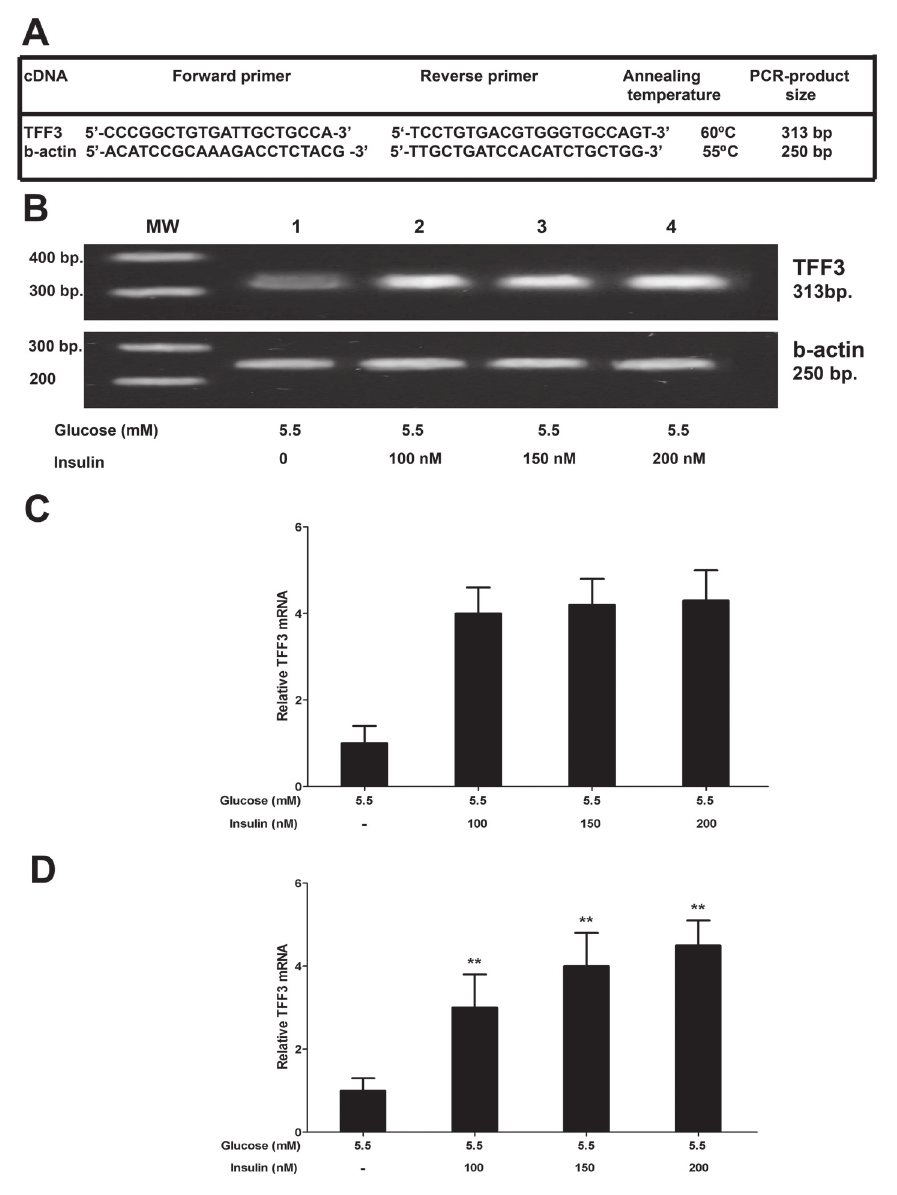
FIGURE 3. Quanti fi cation of differentially-expressed TFF3 mRNA by RT-PCR and RTq-PCR: (A) Speci fi c primers and annealing temperatures employed in semi-quantitative PCR (RT-PCR). (B) RT-PCRs for TFF3 and β -actin were carried out from cell culture samples divided in four groups: Cells treated only with glucose 5.5 mM (lane 1), cells treated with glucose 5.5 mM plus insulin at 100 nM, 150nM and 200 nM (lanes 2, 3 and 4 respectively). The PCR-products were run onto 2% agarose gel electrophoresis. Control reactions without reverse transcriptase were carried out. PCR was performed in a fi nal volume of 25 μ l containing 1 μ l of the reverse transcription reaction, 50 μ M of dNTPs, 1.5mM MgCl2, 50mM Tris–HCl (pH 8.0), 1 IU Taq polymerase and 0.2 μ M each of sense and antisense primers. Speci fi c PCR for a constitutively expressed gene ( β -actin) was carried out as a positive control. The relative amount of product was quanti fi ed by densitometric analysis of DNA bands (C). TFF3-mRNA expression levels are shown normalized to β -actin. (D) Quantitative Real Time-PCR. Results are mean ± SEM of three independent experi- ments.Results are mean ± SEM of three independent